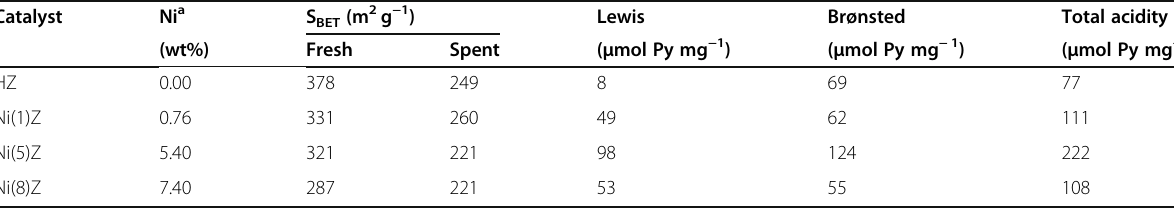
Table 1 Physicochemical and textural characteristics of the catalysts